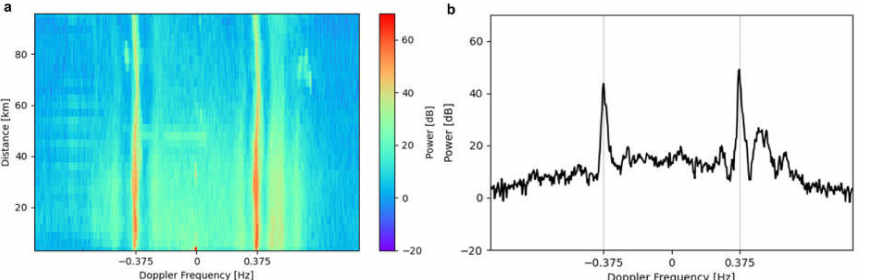
Figure 3. Example of a typical Doppler spectrum. ( a ) The range-Doppler spectrum of Beam 8 at 08:00 a.m. (JST) on 2 November 2020 at Miyazaki Station. A first-order echo peak is seen near ± F b at each distance. ( b ) The Doppler spectrum at 51 km in Figure 3a.